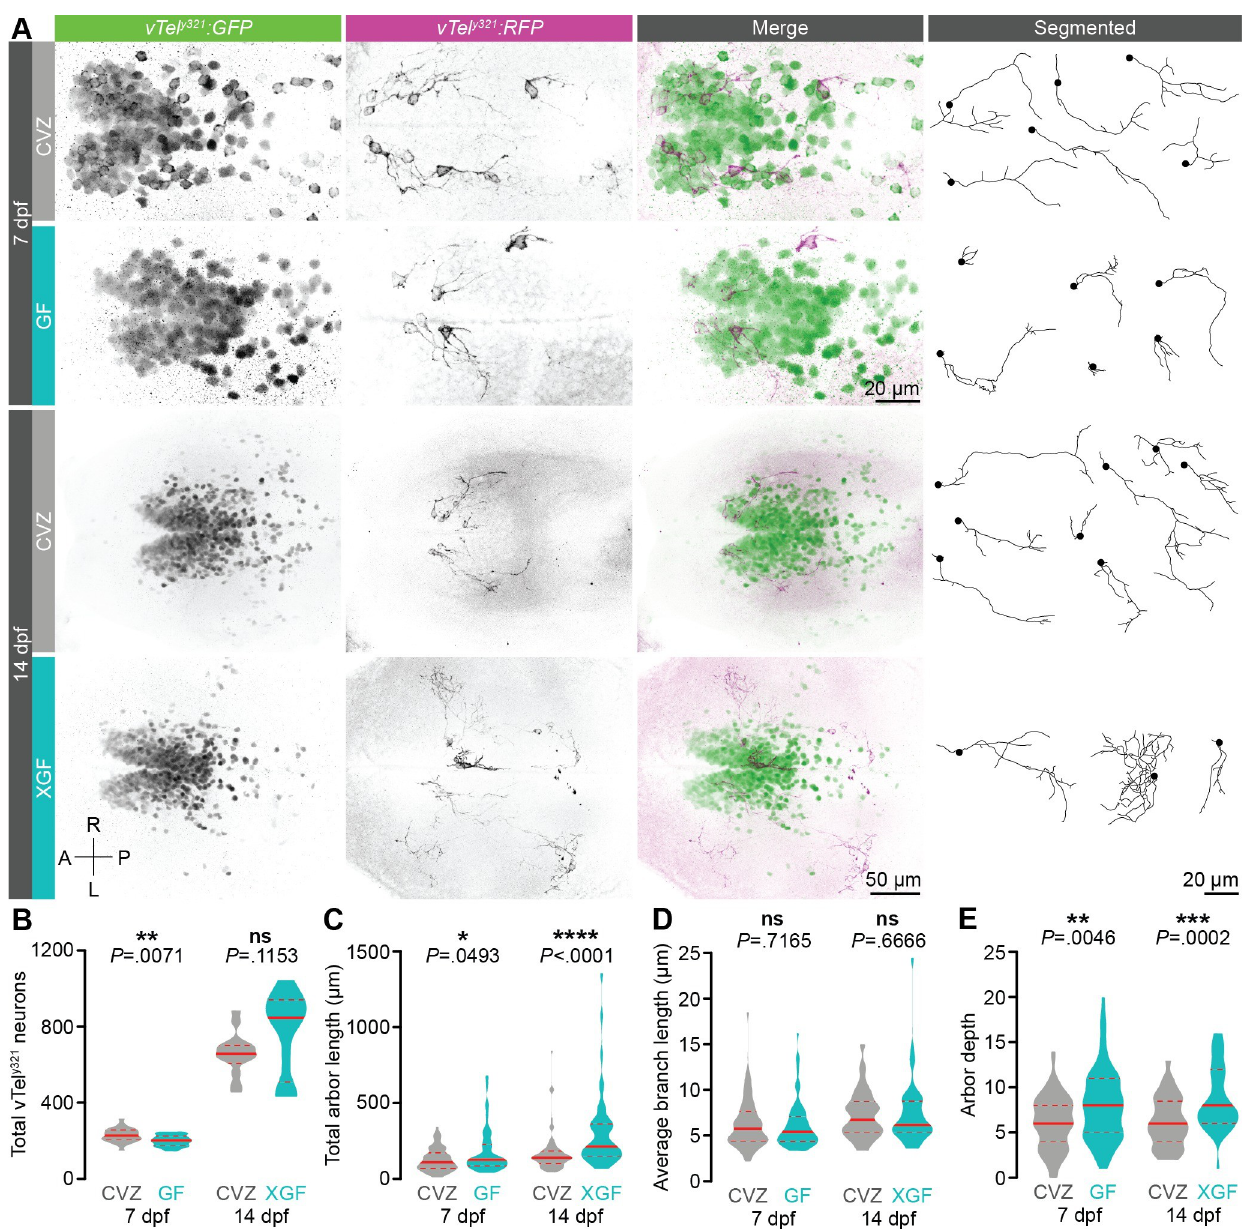
Fig 2. The microbiota restrains vTel y321 arborization. ( A ) Maximum-intensity projections of vTel y321 GFP (green), sparse mosaic vTel y321 RFP (magenta), and individually segmented vTel y321 neurons from the same representative 7 dpf (top) or 14 dpf (bottom) larvae raised CVZ (gray), GF (aqua), or XGF (aqua). ( B ) The total number of vTel y321 GFP neurons is reduced in 7 dpf GF larvae relative to CVZ controls ( n = 24 CVZ and 22 GF larvae; unpaired t test), but not in 14 dpf XGF larvae relative to CVZ controls ( n = 14 CVZ and 12 XGF larvae; Mann–Whitney U test). ( C - E )Total arbor length ( C ) and arbor depth ( E ) are increased and average branch length is unchanged ( D ) in 7 dpf GF larvae relative to CVZ controls ( n = 73 neurons from 24 CVZ larvae and 69 neurons from 25 GF larvae; Mann–Whitney U tests) and in 14 dpf XGF larvae relative to CVZ controls ( n = 69 neurons from 14 CVZ larvae and 46 neurons from 13 XGF larvae; Mann–Whitney U tests). ns, not significant; � , P < .05; �� , P < .01; ��� , P < .001; ���� , P < .0001. Solid red line represents the median; dotted red lines represent the upper and lower quartiles. Data underlying this figure are available on figshare: https://figshare.com/projects/Bruckner_et_al_